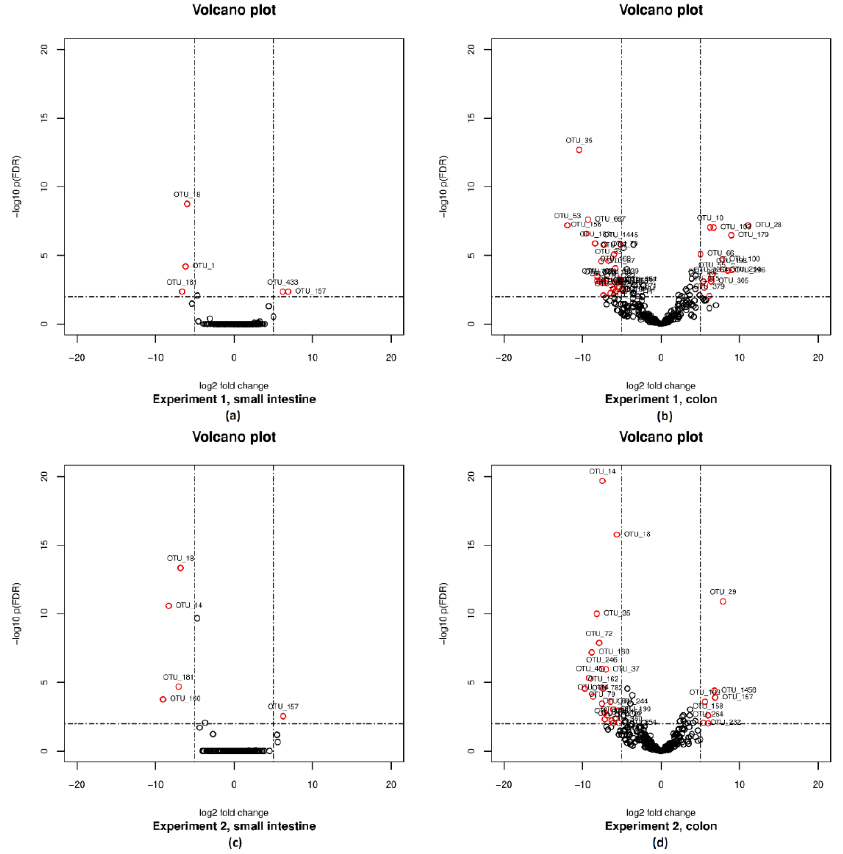
Figure 4. Volcano plot visualizing –log10 false discovery rate (FDR)-adjusted p -values versus log2 fold changes for all 531 OTUs. The horizontal lines show the significance threshold for an FDR < 0.01. Each open point represents a single OTU in ( a ) Experiment 1, small intestine; ( b ) Experiment 1, colon; ( c ) Experiment 2, small intestine, and ( d ) Experiment 2, colon. Open points above the significance threshold and beyond the log2 fold change criterion of ±5 are colored red.